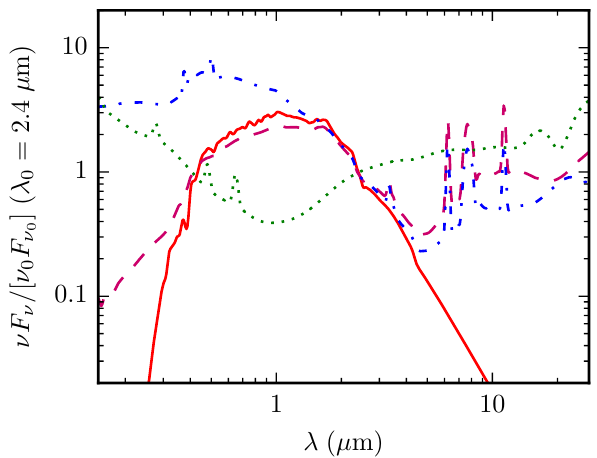
Figure 1. The template spectra used from Assef et al. (2010). The red solid line is the template called “Elliptical.” The purple dashed line is “Sbc.” The blue dash-dotted line is “Irregular.” And the green dotted line is “AGN,”